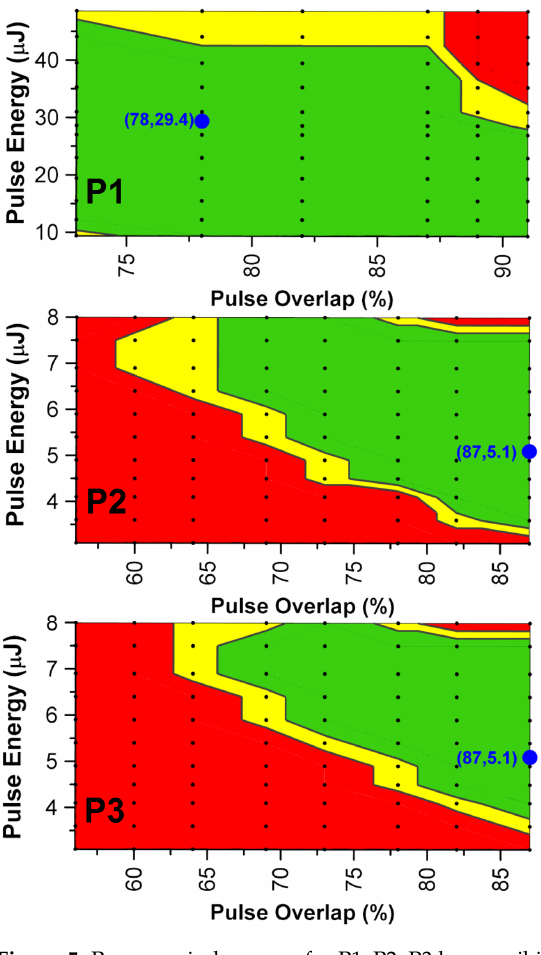
Figure 5. Process window map for P1, P2, P3 laser scribing. Black dots represent the parameters used for the devices.